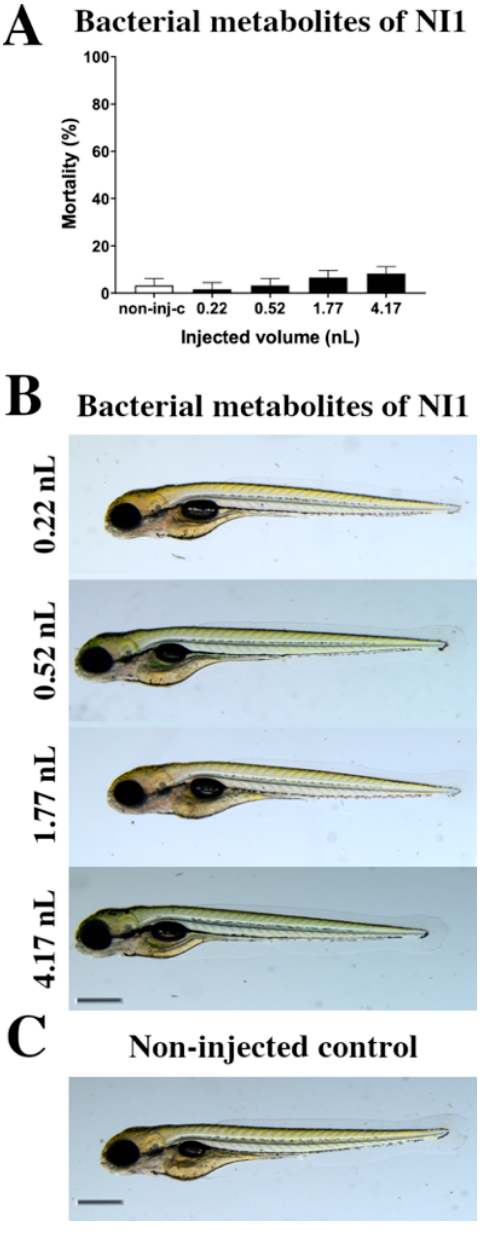
Figure 1. Effects of the Rhodococcus erythropolis NI1 strain bacterial metabolites on 120 hpf zebrafish embryos. Mortality results of NI1 strain bacterial metabolites ( A ) were checked following 120 h of injection. Lethality data are expressed as mean ± SD from three independent experiments in triplicate. Kruskal–Wallis followed by Dunn’s post-hoc test was used. Mortality values were compared to the non-injected control (non-inj-c). Larvae had no phenotypic lesions ( B ) at either dose after 120 h of injection. Scale bar: 1 mm. Phenotypes of treated groups were compared to the non-injected control